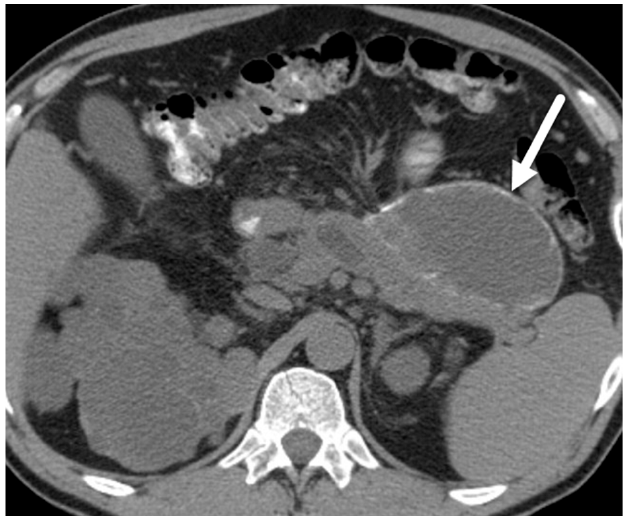
Figure 7. Pseudocyst. Axial CT without IV contrast demonstrates a cystic lesion with rim calcification in the pancreatic tail (arrow). Cyst analysis confirmed a pseudocyst.